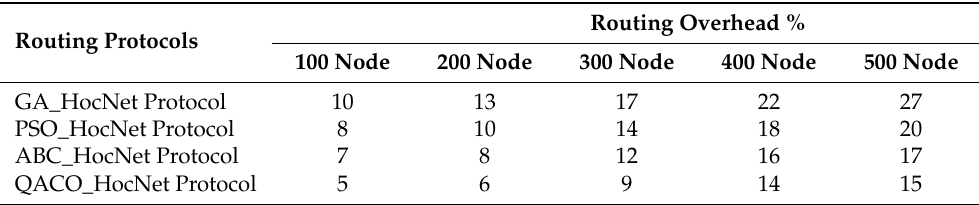
Table 9. Overhead routing results for different metaheuristics-based MENT routing protocols over various simulation node